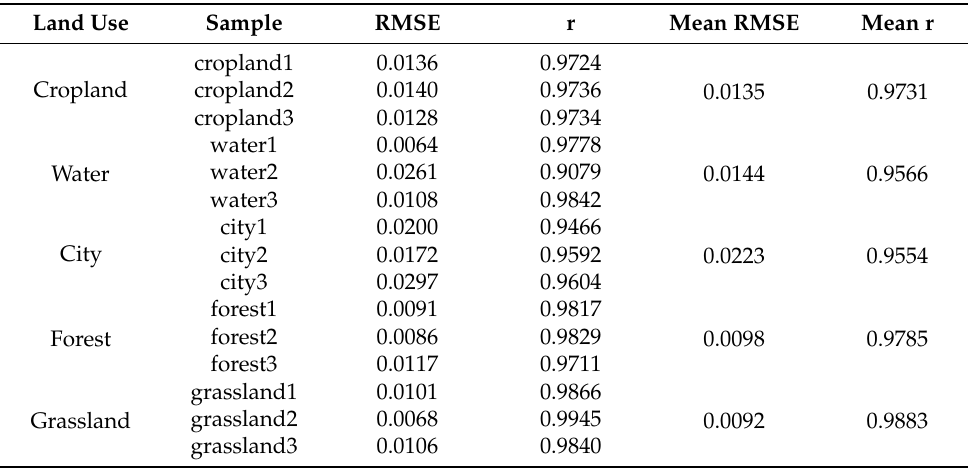
Table 2. RMSE and r values of the Sentinel-2 images before and after cloud removal.